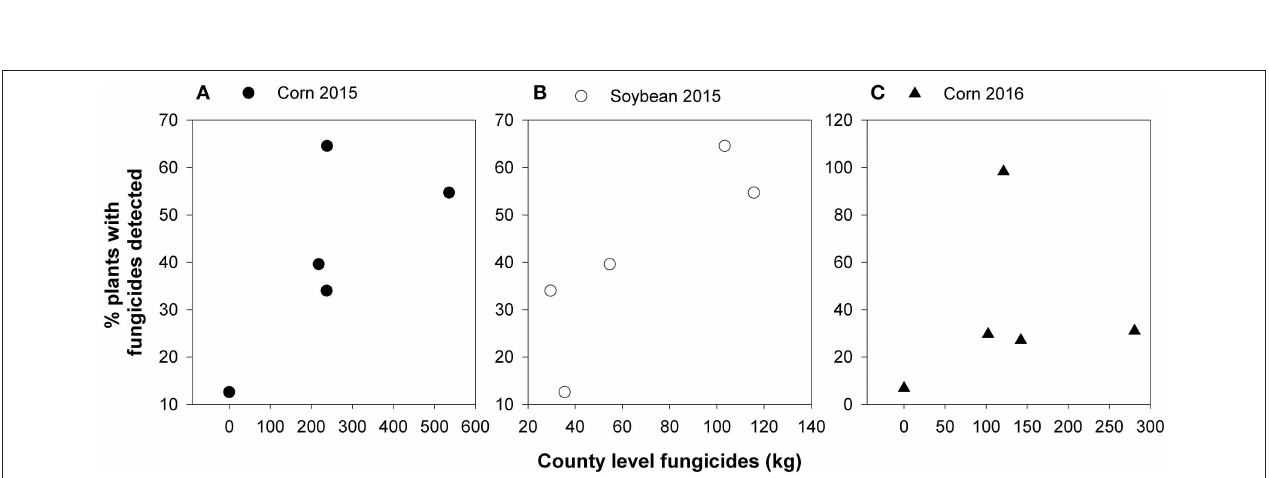
FIGURE 8 | Relationship between amounts of corn (A,C) and soybean (B) fungicides used in Tippecanoe County in 2015 and 2016 vs. the percent of plants with detectable levels of fungicides. Data points show each of the five fungicides detected in our analysis.